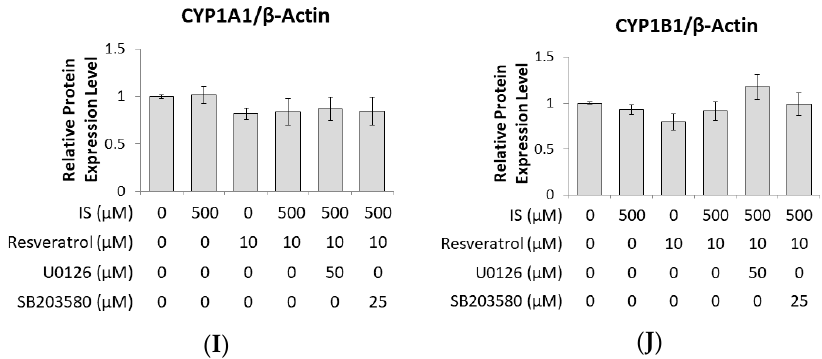
Figure 5. The e ff ect of MAPK inhibitors on osteogenesis markers and the AhR pathway. After 1 h of U0126 or SB203580 stimulation, MC3T3 E1 cells were cultured in an osteogenesis medium with IS at 0, 100, 500, and 1000 µ M with or without RSV. ( A – C ) After 2 h of culture at 500 µ M IS and 10 µ M RSV, ERK1 / 2 and p38 MAPK phosphorylation was significantly decreased in U0126 and SB203580, respectively. ( D – G ) After 2 or 7 days of culture, both U0126 and SB203580 significantly suppressed the protein expression of Runx2, collagen 1, and osteocalcin for IS and RSV at 500 and 10 µ M, respectively. ( H – J ) After 2 days of culture, neither U0126 nor SB203580 influenced the protein expression of CYP1A1 and CYP1B1 at 500 µ M with 10 µ M RSV. Data are represented as the mean ± SEM ( n = 3). * Indicates di ff erences that were considered significant between the indicated groups ( p < 0.05).